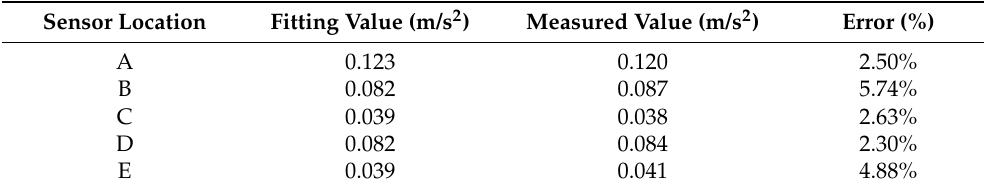
Figure 19. Peak acceleration response: ( a ) acceleration responses at position “A”; ( b ) measured acceleration value and model curve. Table 9. Comparison of measurement results.